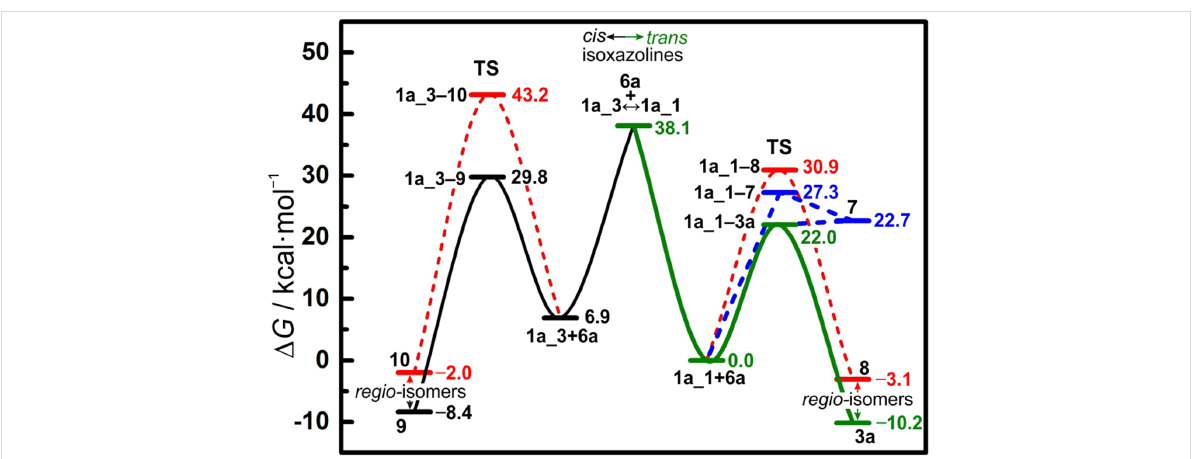
Figure 7: Summary of the calculated pathways of the cycloaddition reaction between enamine 1a and benzonitrile oxide 6a . The pathway leading to the observed product is highlighted green. Values of the free energies are given in respect to the sum of free energies of enamine 1a_1 and nitrile oxide 6a at the optimized